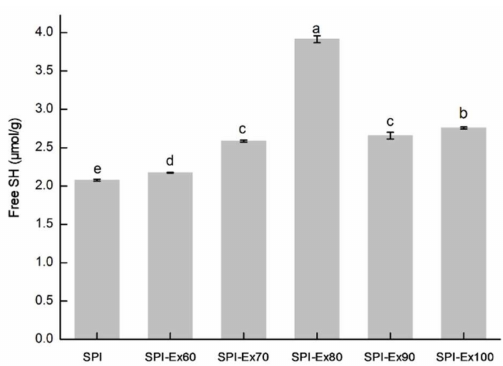
Figure 3. SDS-PAGE images of SPI extracted from full-fat soybean flakes powder with and without extrusion treatment.